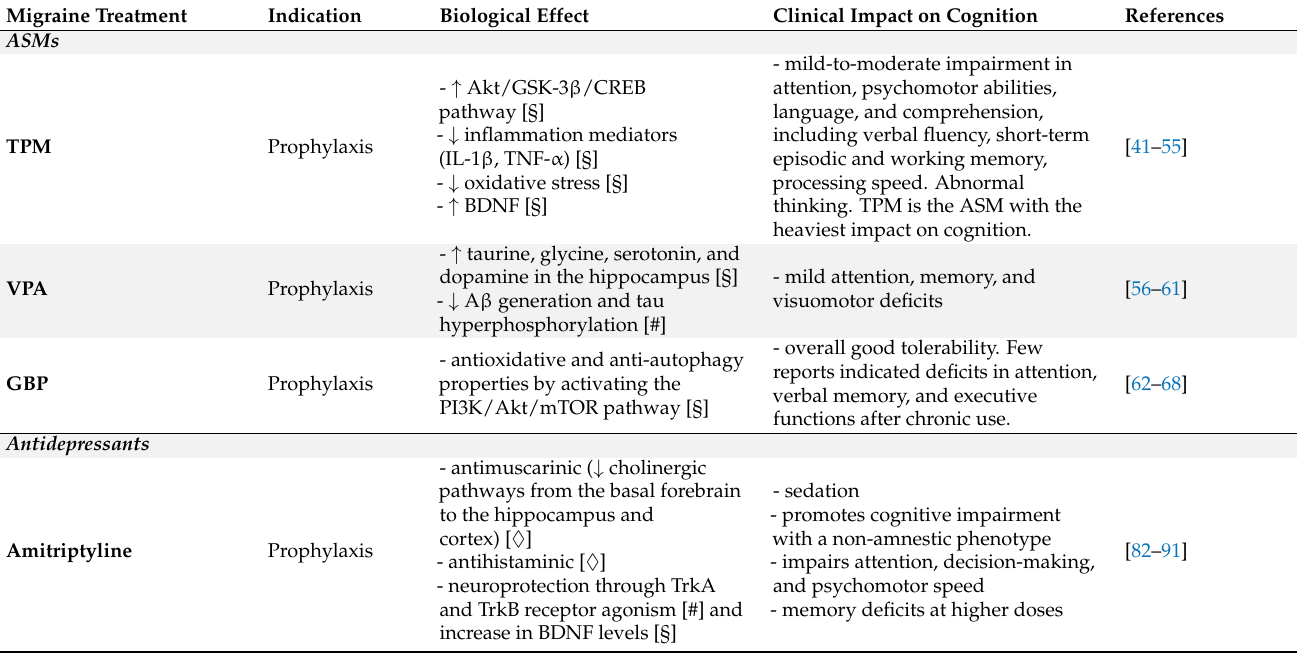
Table 1. Summary of findings on the role of anti-migraine therapies on cognition and neurodegeneration. Migraine Treatment